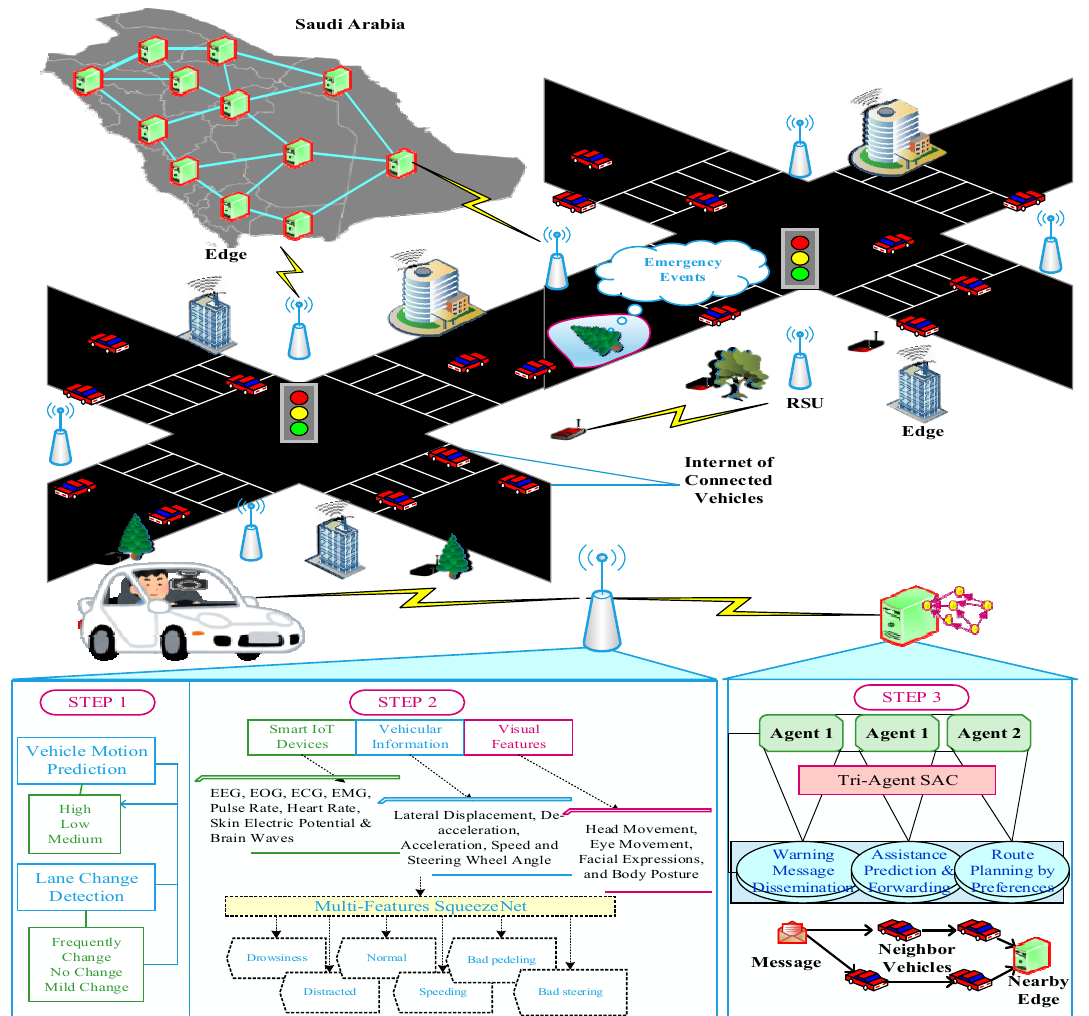
Figure 2. Overall architecture of MODAL-IoCV.